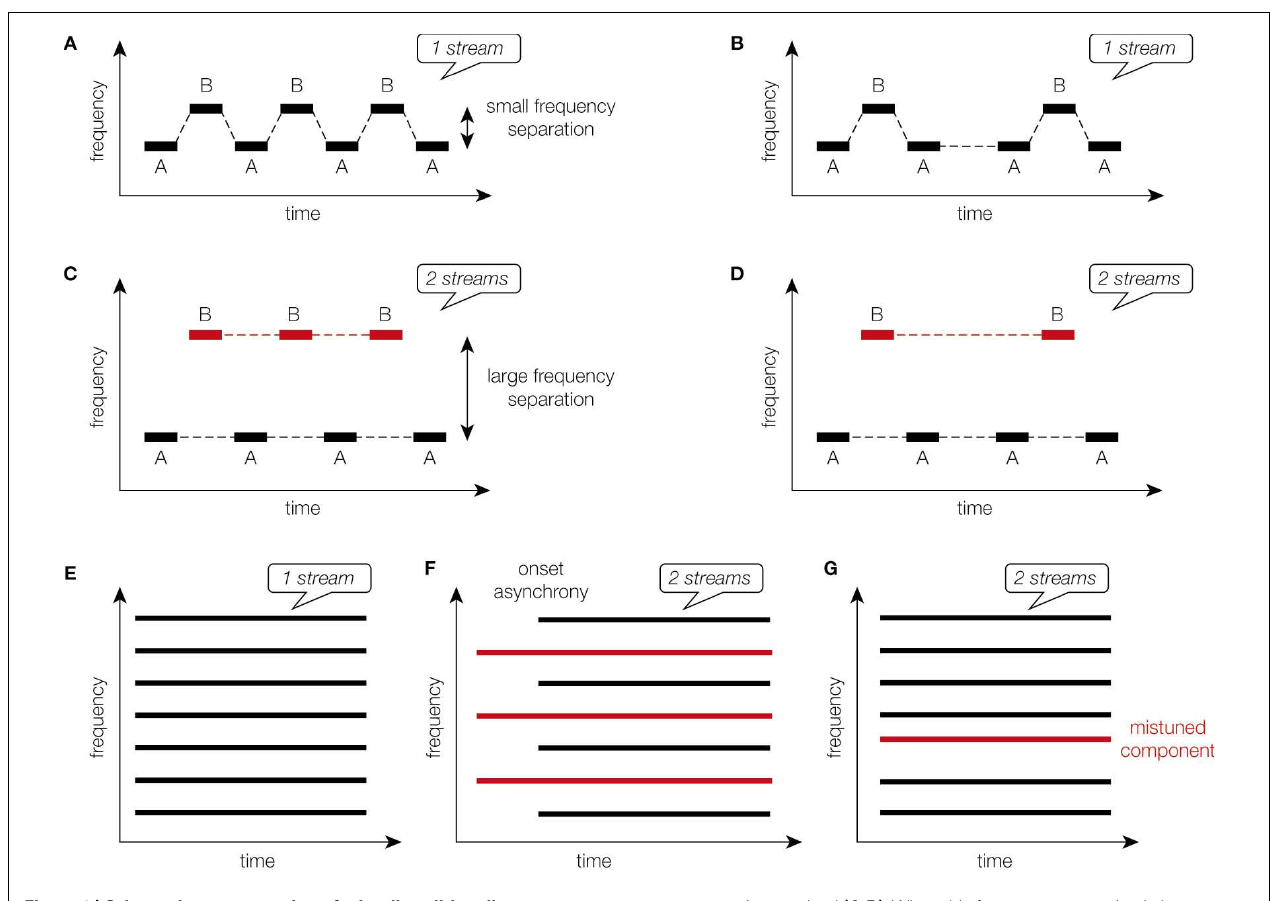
Figure 1 | Schematic representation of stimuli traditionally used to investigate auditory perceptual organization. Sequential segregation can be explored using alternating pure tones following an ABAB (A,C) or an ABA_ (B,D) pattern (“_” corresponds to a silence). When the frequency separation between A and B tones is small,